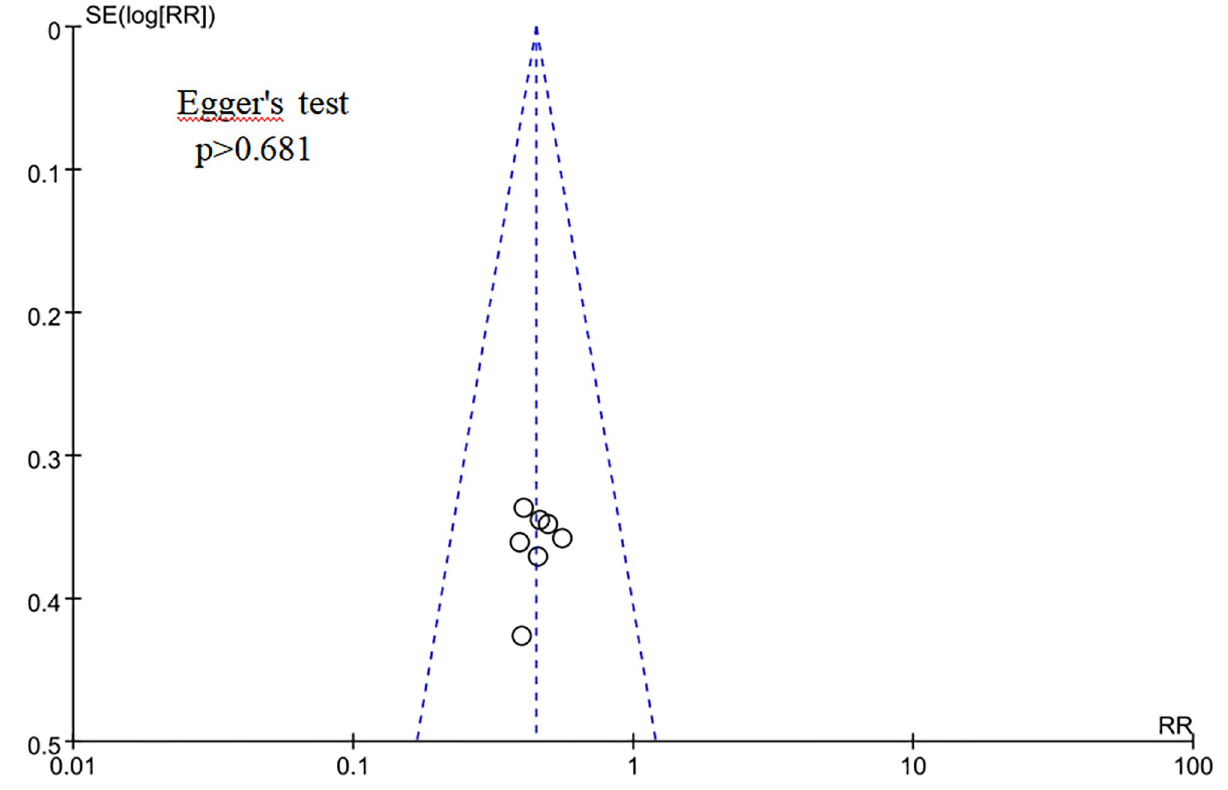
Fig 8. Funnel plot of recurrence